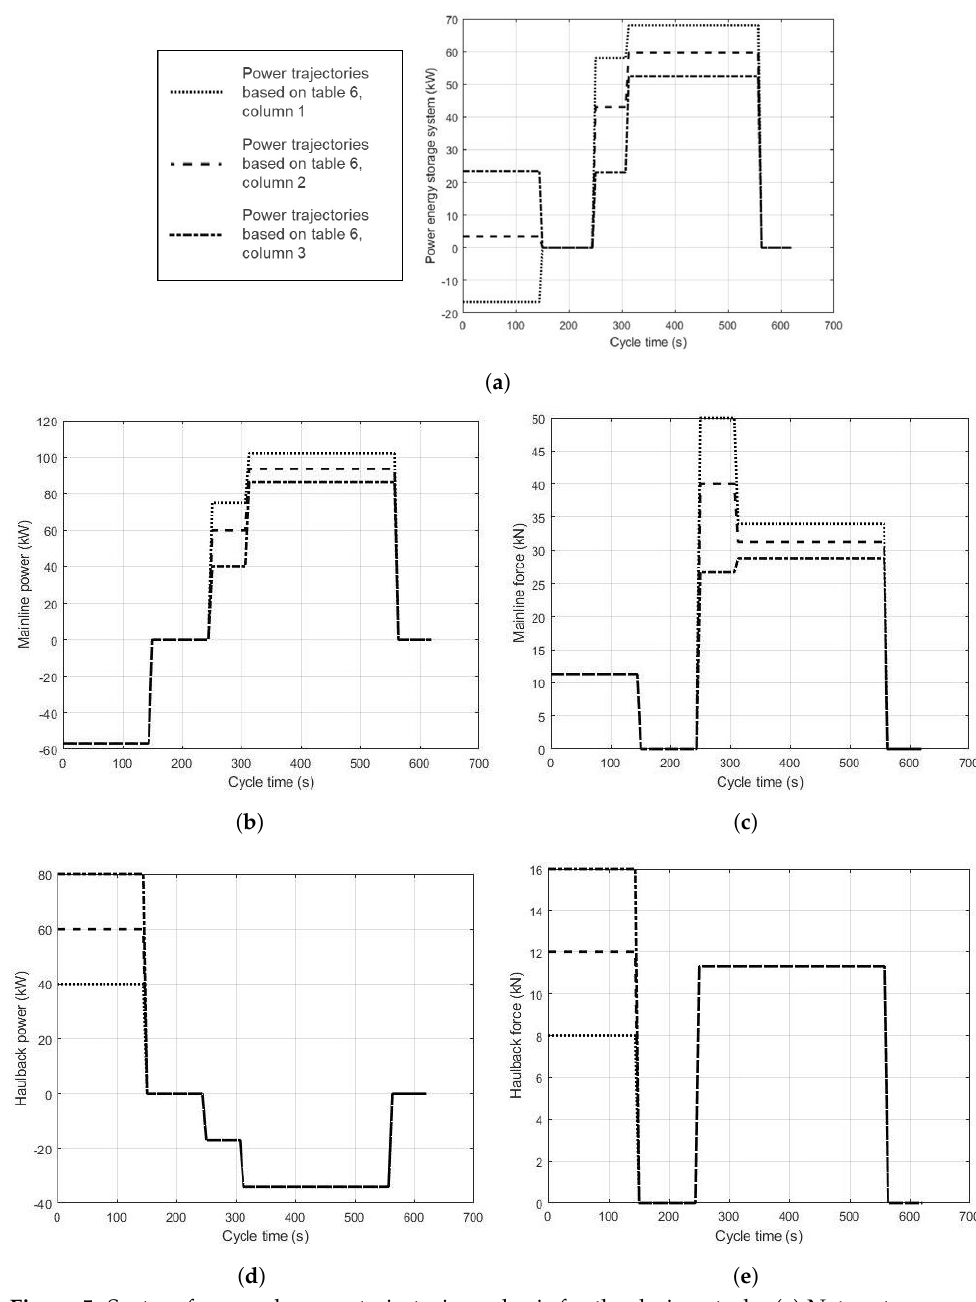
Figure 5. System force and power trajectories as basis for the design study. ( a ) Net system power drawn by mainline and haulback line; equivalent to the power of the energy storage system. ( b ) Mainline power trajectories. ( c ) Mainline force trajectories. ( d ) Haulback power trajectories. ( e ) Haulback force trajectories.